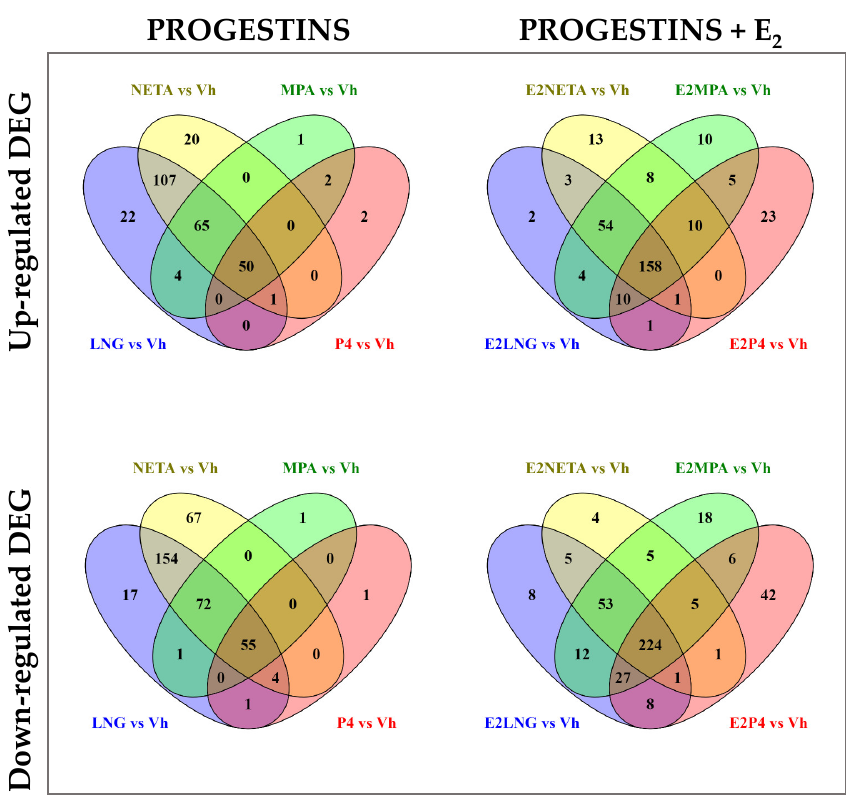
Figure 2. Venn diagram of di ff erentially expressed genes among the four progestins alone or in combination with E 2 . Upper panel shows Venn diagrams of up-regulated DEG for each progestin versus Vehicle alone (left panel), or in combination with E 2 (right panel). Lower panel shows Venn diagrams of down-regulated genes for each progestin versus vehicle alone (left panel), or in combination with E 2 (right panel). Fold change (FC) ≥ 1.5 and Benjamini-Hochberg adjusted p < 0.05.